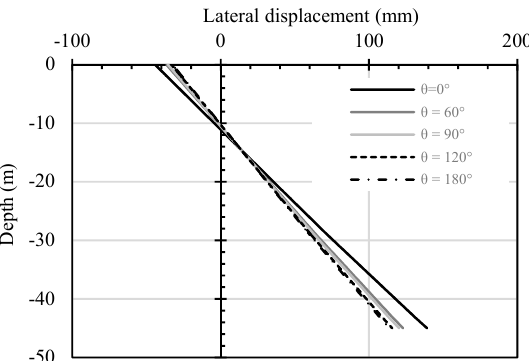
Figure 14. The distribution curve of lateral displacement along the depth of a caisson with different reinforcement angles.